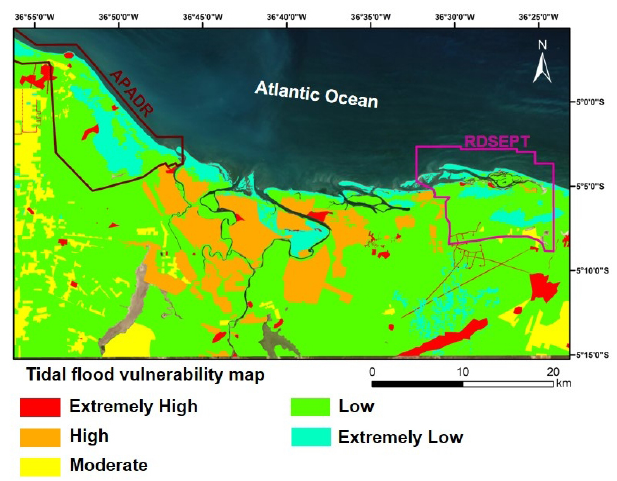
Figure 10. Tidal flood vulnerability map.